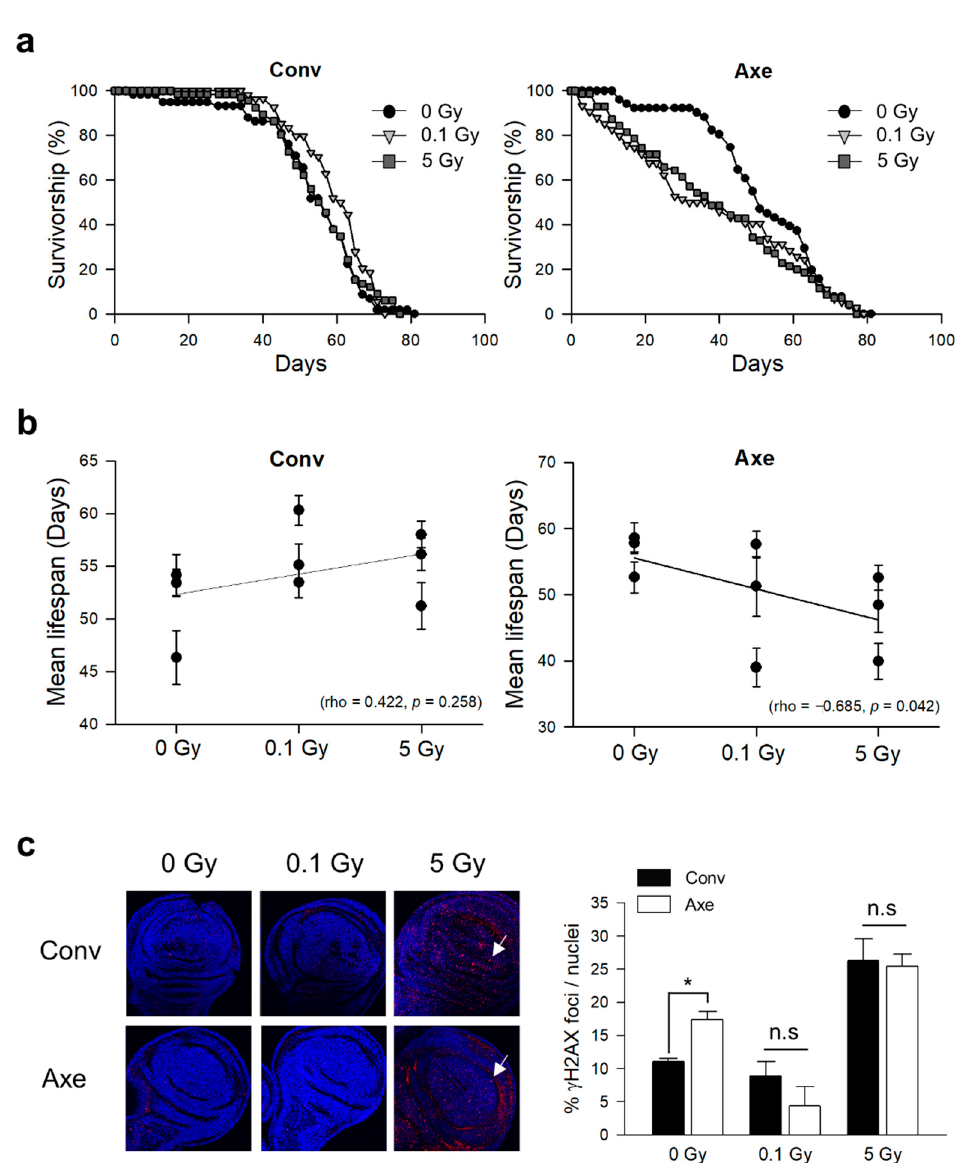
Figure 2. Effects of commensal microbes on the lifespan and DNA damage response of D . melanogaster after γ -ray irradiation. ( a ) Representative survival of the conventional (Conv) and axenic (Axe) flies after γ -ray irradiation at the third instar larval stage. ( b ) Mean lifespan of the Conv (Spearman’s correlation, rho = 0.422, p = 0.258) and Axe (Spearman’s correlation, rho = − 0.685, p = 0.042) flies according to the radiation dose. The error bars represent the SEM. ( c ) The formation of radiation-induced γ H2AX foci on wing imaginal discs of flies after γ -ray irradiation. Phosphorylated H2AX was used as a marker of DNA double-strand breaks. Foci on the imaginal discs of the Conv and Axe third instar larvae were detected by immunostaining with the specific antibodies for γ H2AX. The arrows indicate the foci of DNA double-strand breaks on the wing imaginal discs of D . melanogaster . DAPI was used to stain the nuclei (blue). Original magnification was 400×. The graph represents the ratio of detected area of γ H2AX foci to nuclei based on confocal microscopy images. Student’s t -test, * p < 0.05. n.s, not significant. The error bars represent the SEM.